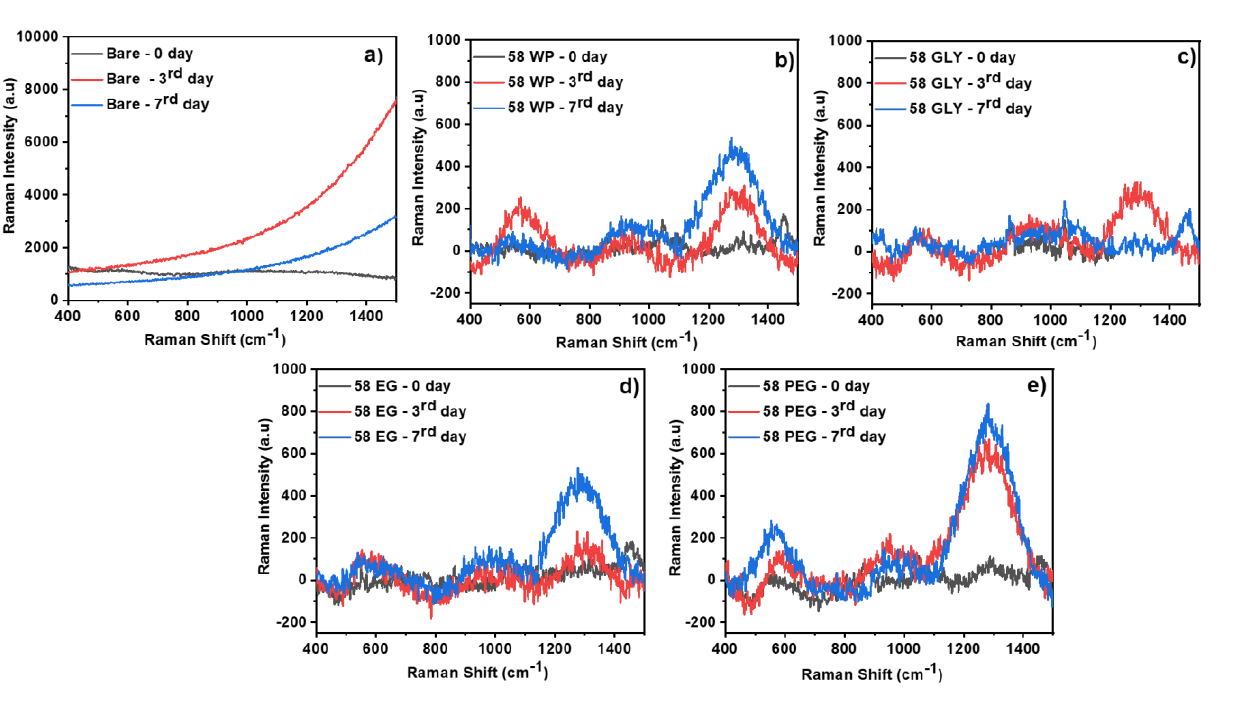
Figure 6. Raman spectra of AZ31B alloys ( a ), 58S WP coating ( b ), 58S GLY coating ( c ), 58S EG coating 393 ( d ), and 58S PEG coating ( e ) maintained in Hank’s solution for 3 and 7 days. 394